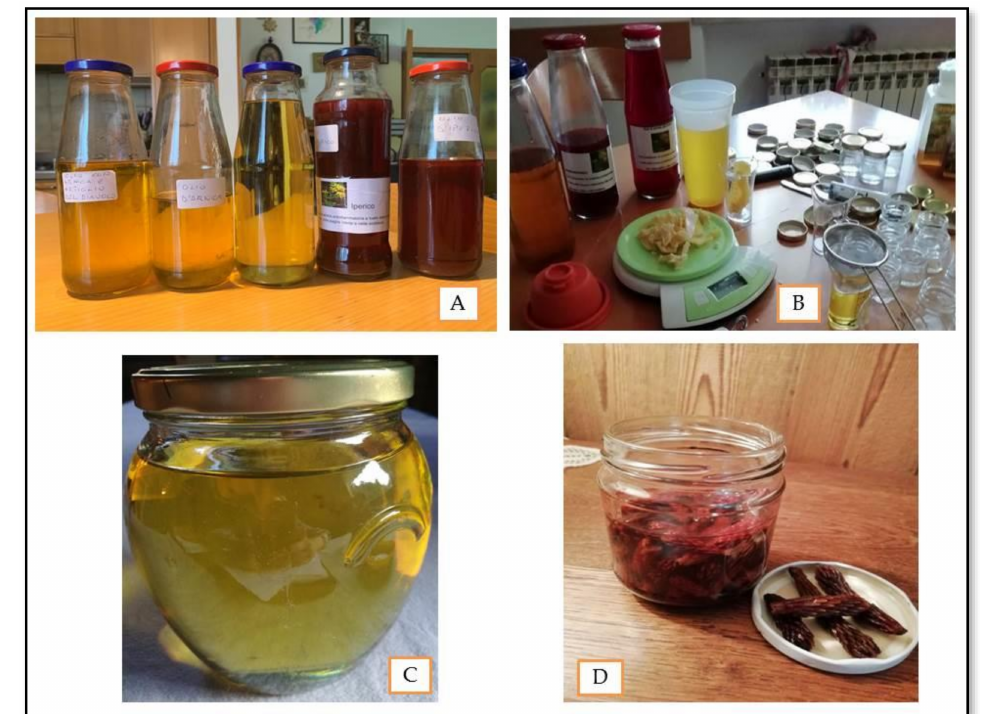
Figure 3. Common “in-house” packaging of traditional preparations: oleolyte ( A , B ), ointment traditionally called “ünt del tai” ( C ), and Mugolio ( D